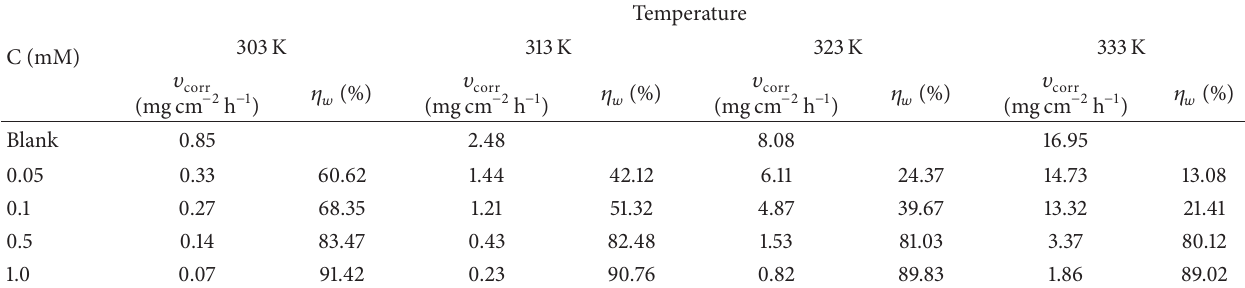
Table 1: Effect of temperature on the corrosion rate of mild steel in 1M HCl at different concentrations of RS.